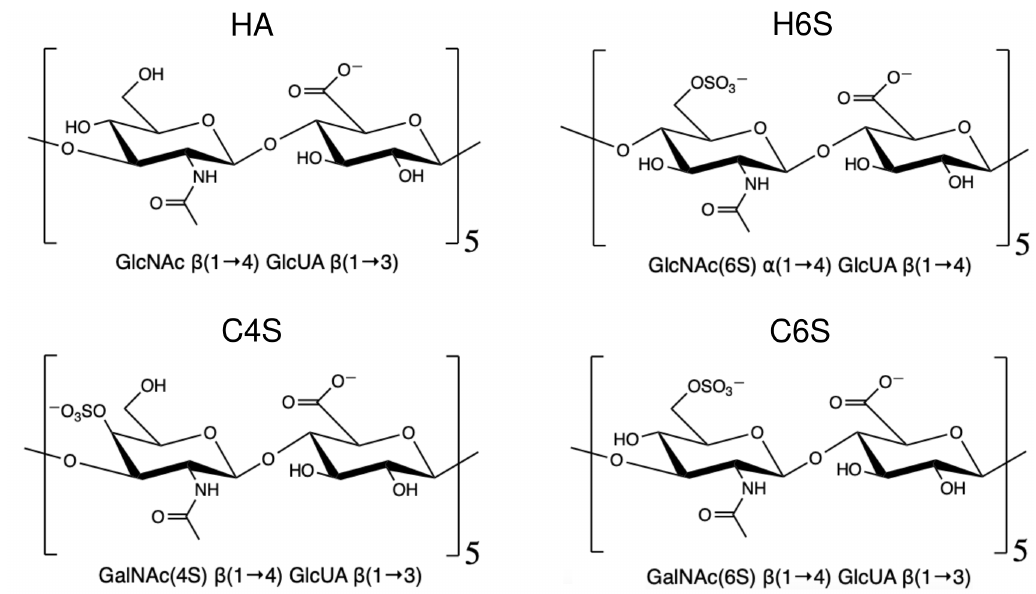
Figure 1. Chemical structure of the GAGs considered in this work. The disaccharide unit of each GAG is shown, and five repeating disaccharides were simulated in each